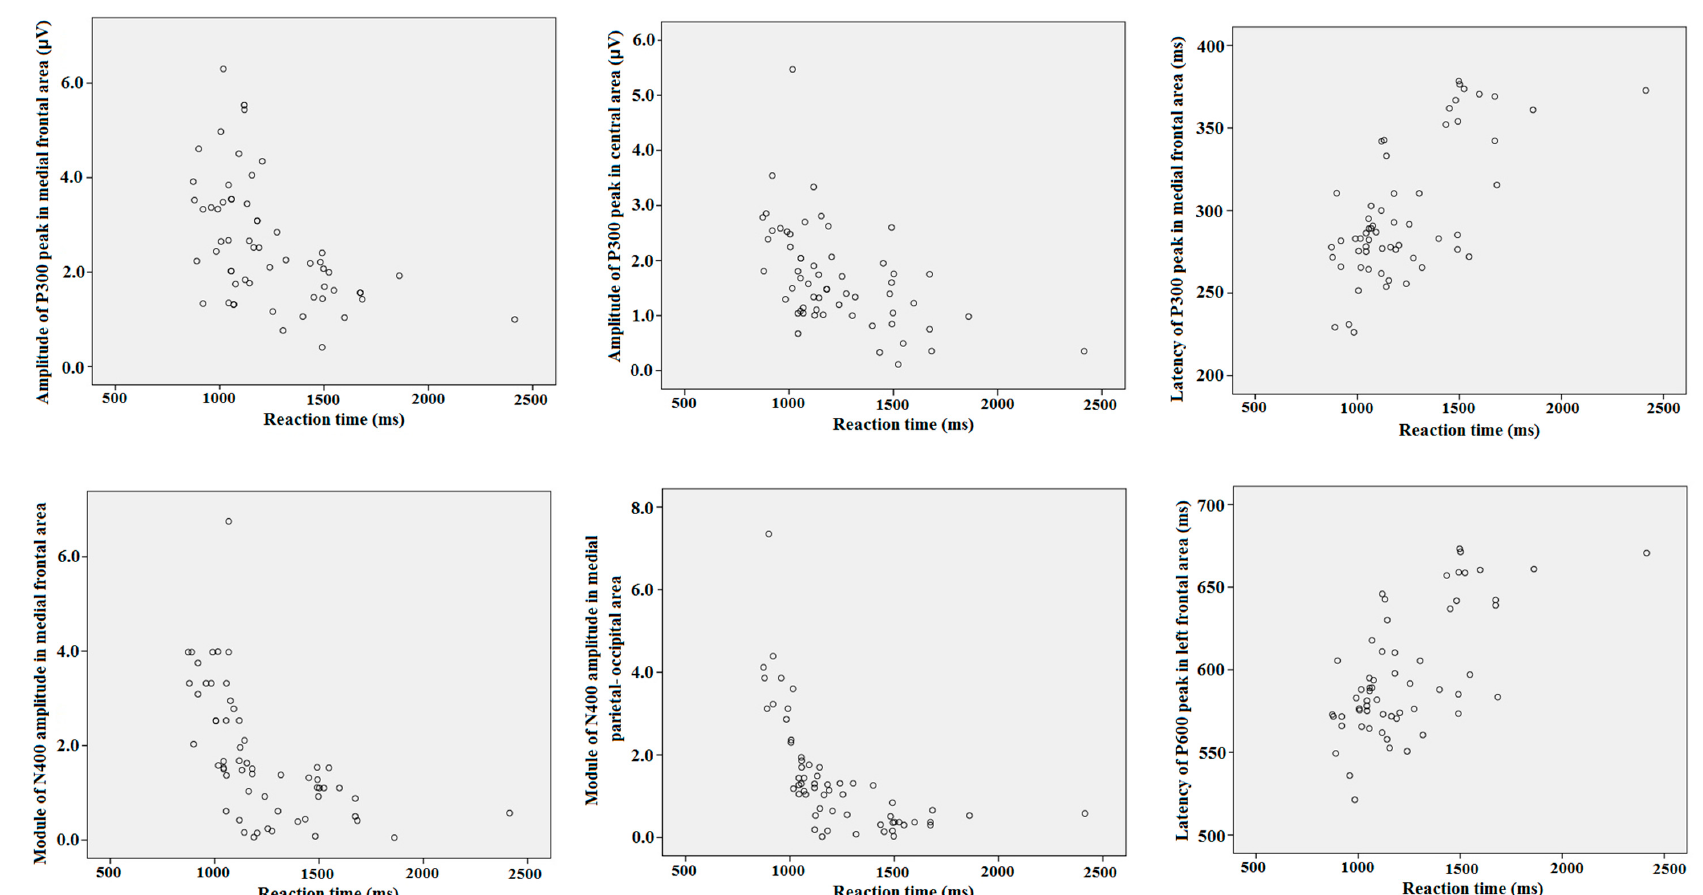
Figure 6. The scatter plots for correlations between reaction time and ERP peaks latency and amplitude in different cortical areas.